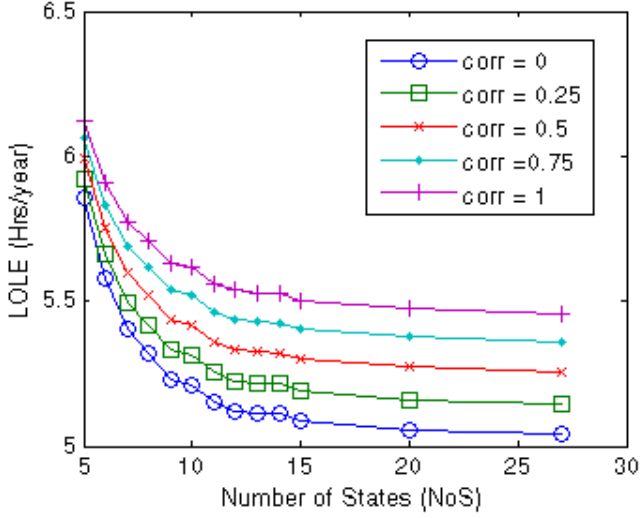
Figure 8. Variation in LOLE results with the NoS in the wind model at different wind